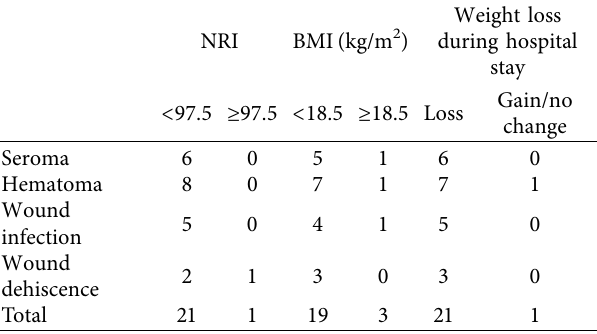
Table 2: Distribution types of wound healing complication according to different parameters in Wolaita zone, Southern Ethiopia, October 2016.